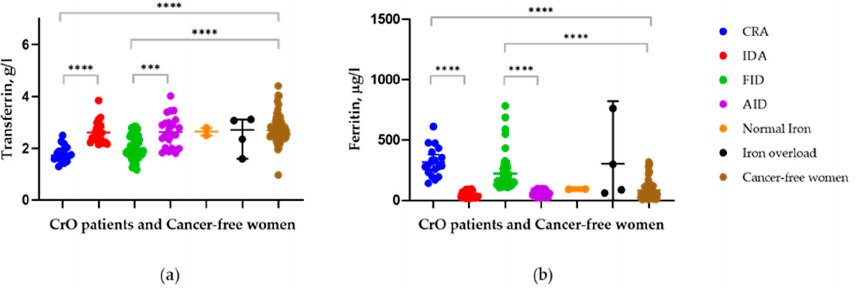
Figure 2. Transferrin ( a ) and ferritin ( b ) levels in groups of CrO patients with different iron statuses and in the cancer-free women (Control). Note: *** p < 0.001; **** p < 0.0001. p — p -value. The transferrin levels in both FID and CRA patients are significantly lower compared to the AID, IDA, normal iron status, iron overload, and control (Tables 4 and 5). Table 4. Indicators of transferrin, serum ferritin, transferrin saturation, and hemoglobin across dif- ferent types of iron status in ovarian cancer patients.